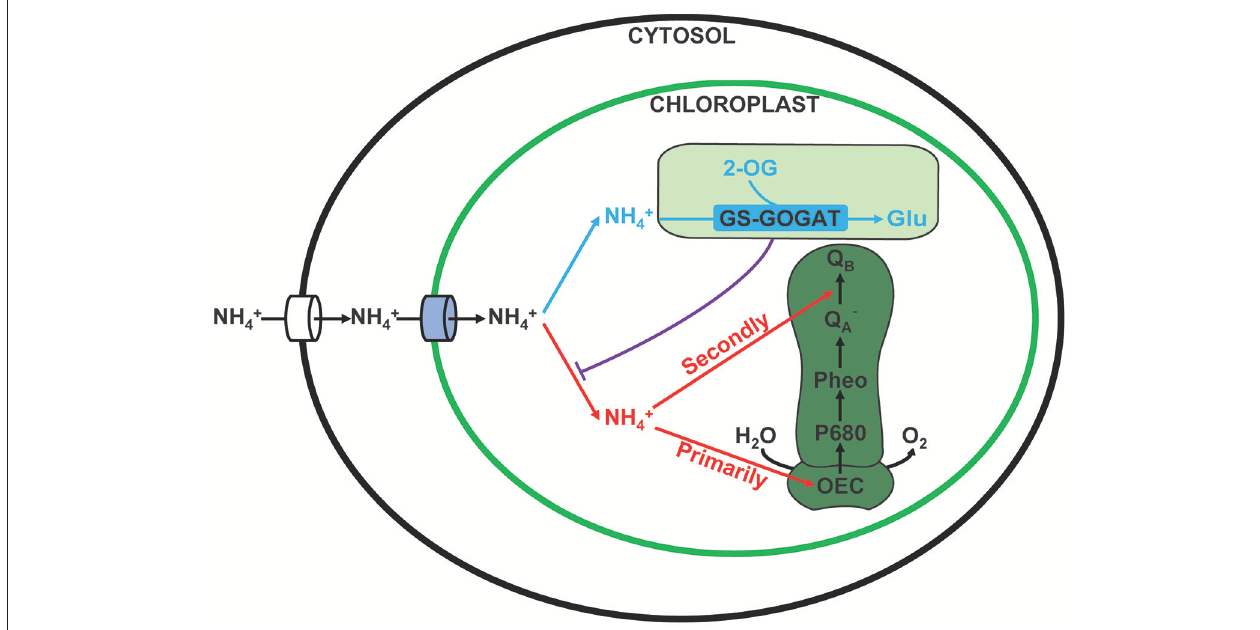
FIGURE 10 | Competition between assimilation and PSII damage by ammonium nitrogen in the chloroplast. When ammonium nitrogen was transported into the chloroplast, it could be taken as: 1. N source and being assimilated into nontoxic organic nitrogen by GS-GOGAT (in blue), and 2. hazardous material that being toxic to photosynthesis, which initially damaging the OEC and then blocking electron transport from Q − A to Q B (in red). The damaging effects on PSII are dependent on the assimilation rate, which is further up to the activities of the